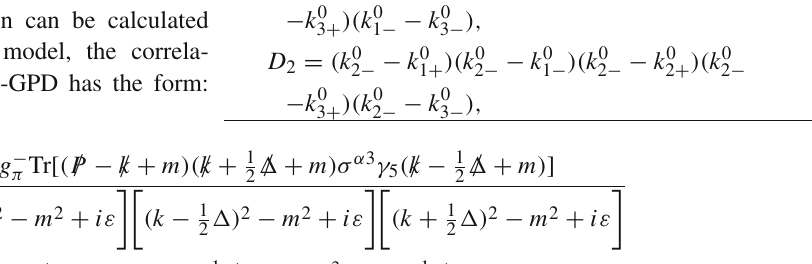
Fig. 2 The T-odd GTMD ˜ G o ˜ G o ( x ,ξ, (cid:2) k 2 , (cid:2) (cid:3) 2 ) at ξ = 0 . 1 and 0 . 5, respectively. The left and right panels ˜ G o T T 1